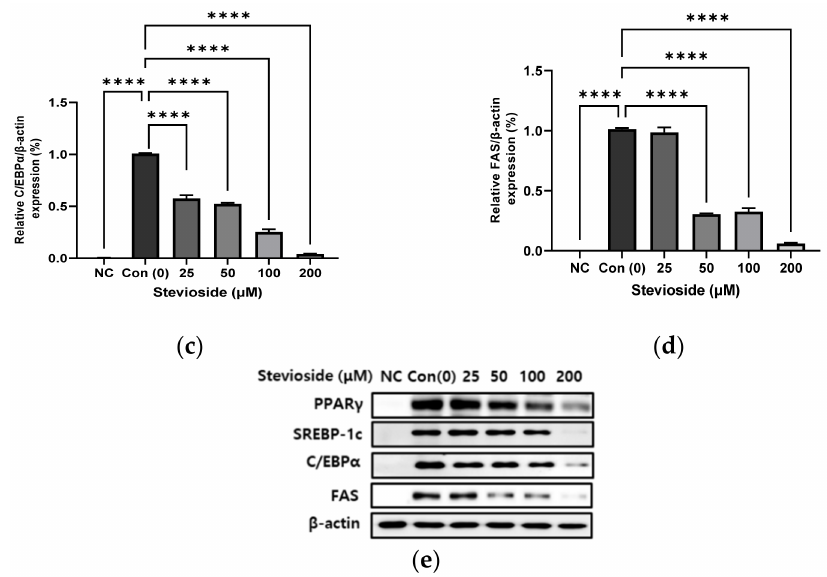
Figure 2. The effect of stevioside on the expression of the adipogenic related proteins in 3T3-L1 cells. Relative protein expressions of ( a ) peroxisome proliferator-activated receptor gamma (PPAR γ ), ( b ) sterol regulatory element-binding transcription factor-1c (SREBP-1c), ( c ) CCAAT/enhancer- binding protein alpha (C/EBP α ), and ( d ) Fatty acid synthase (FAS) were normalized with β - actin. ( e ) Immunoblot analysis of adipogenic related genes in 3T3-L1 cells. All data are pre- sented as mean ± SD, and tests were performed in three independent experiments. ** p < 0.01 and **** p < 0.0001. Negative control (NC) was not treated with an adipocyte differentiation